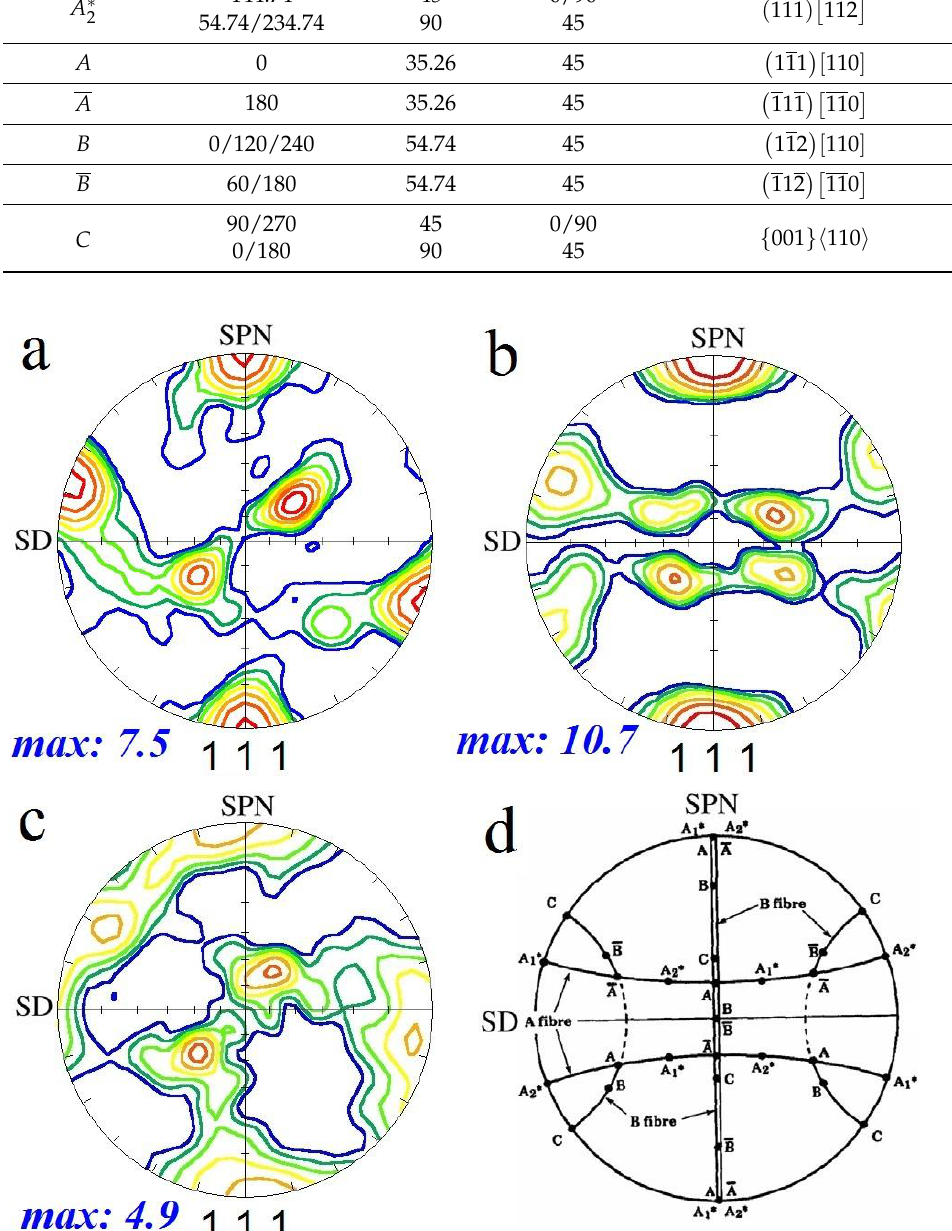
Figure 10. (111) pole figures of different SZs: ( a ) S1, ( b ) S2, and ( c ) S3. SD and SPN denote the shear and shear plane normal directions. ( d ) Ideal simple shear texture components of metals with face-centered crystallographic (FCC) structures [22].